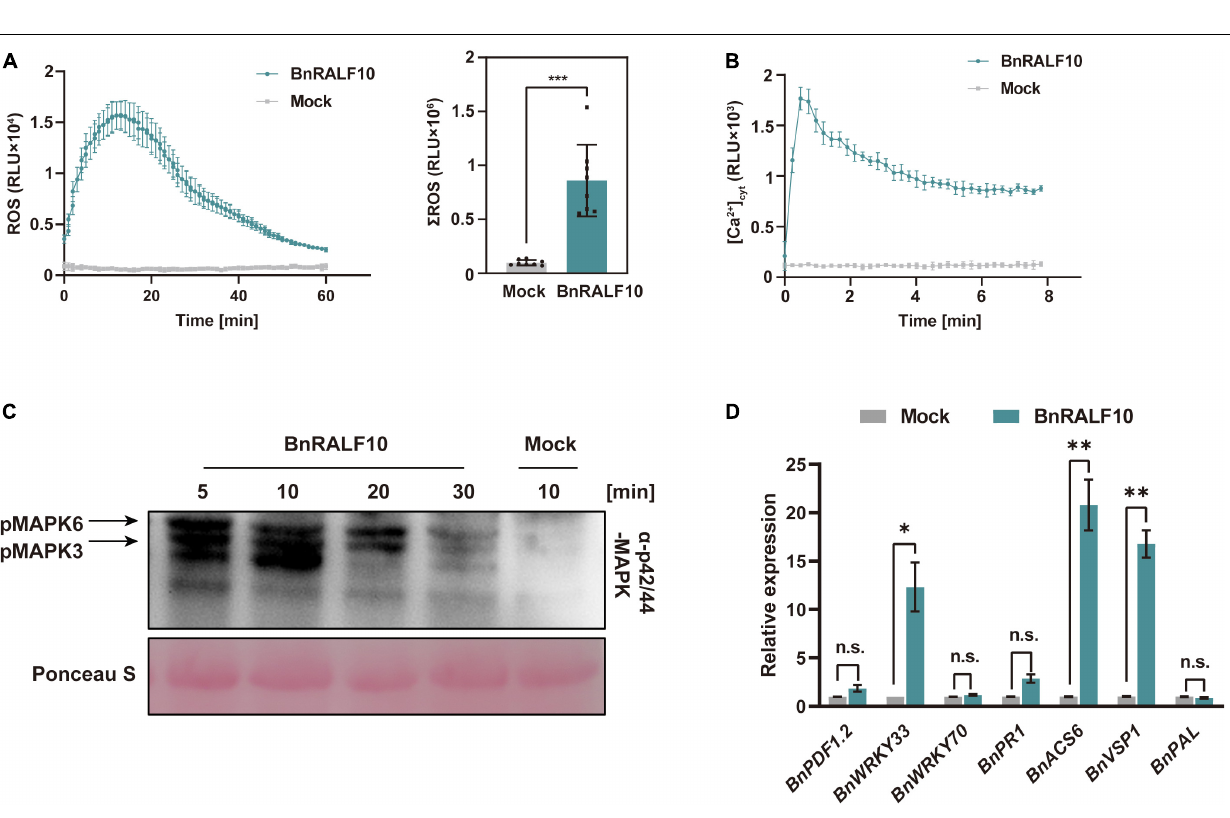
Frontiers in Plant Science |